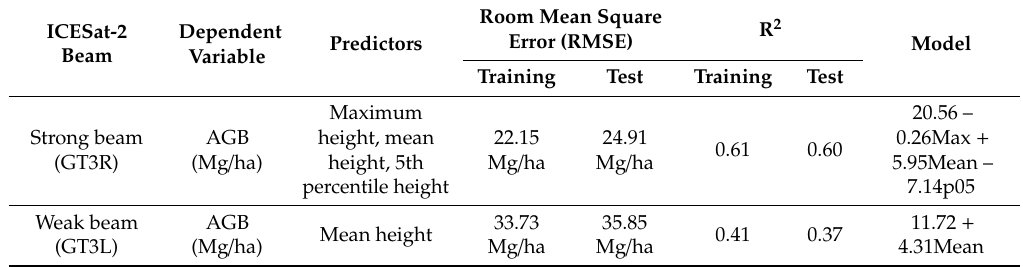
Table 3. Regression models for estimating AGB with ICESat-2 data from the strong beam and weak